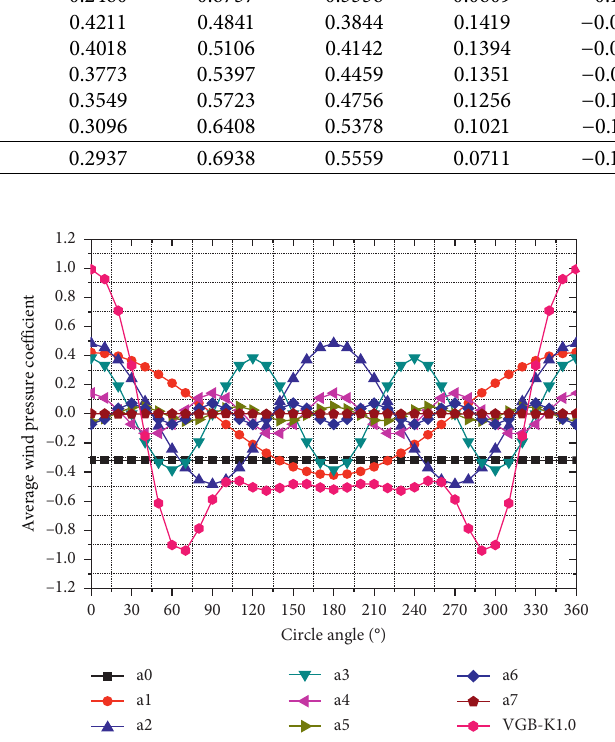
Figure 13: Pressure curves of each harmonic component